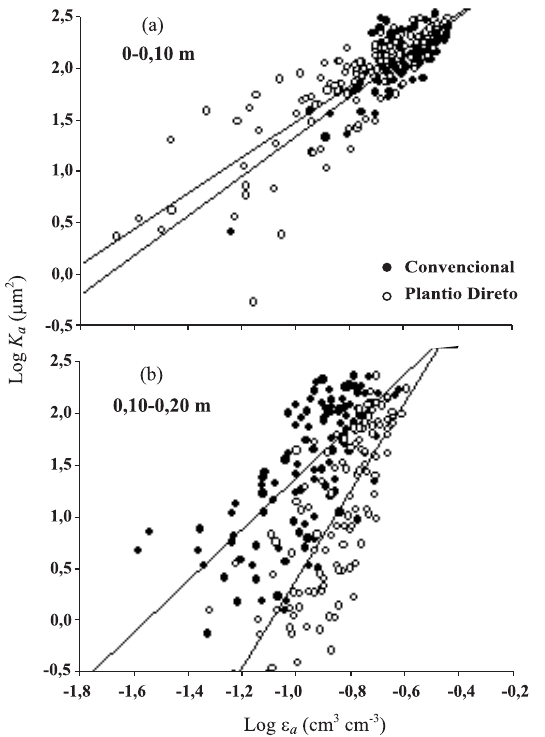
e εεεεε de um a a